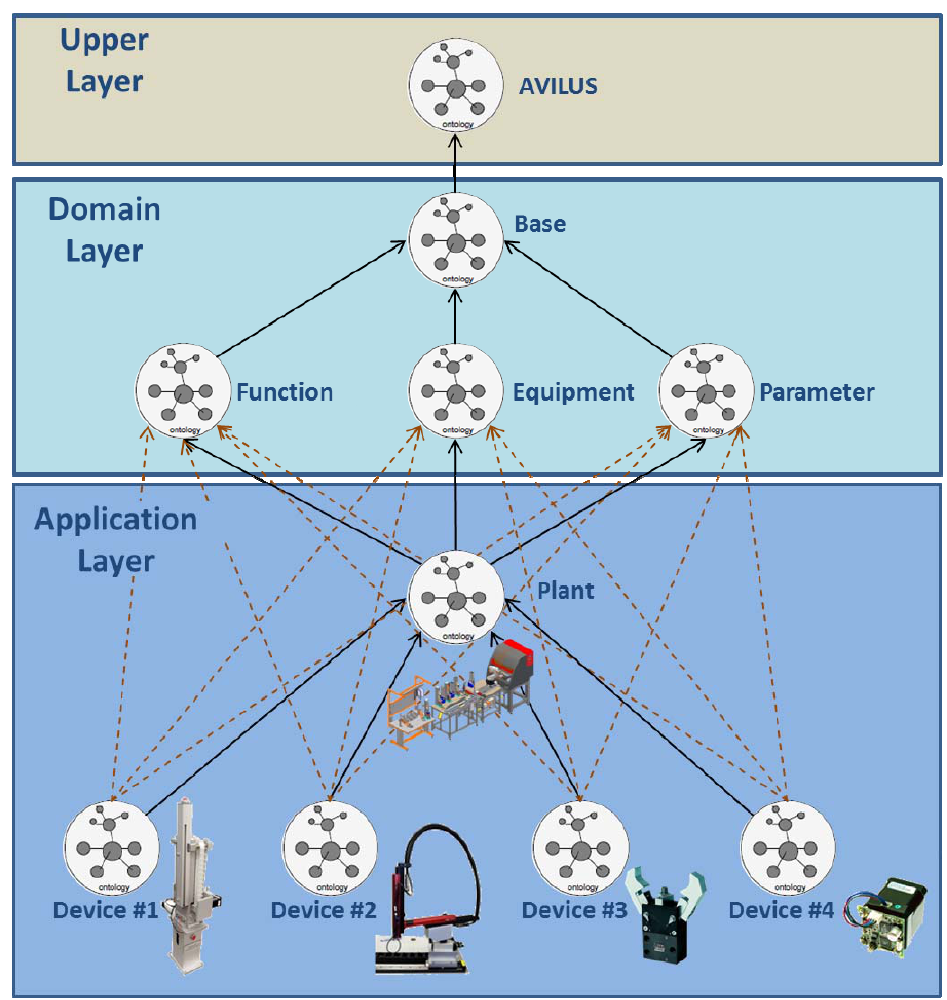
Figure 1. Structure of modular ontologies for the semantic service description and context-based